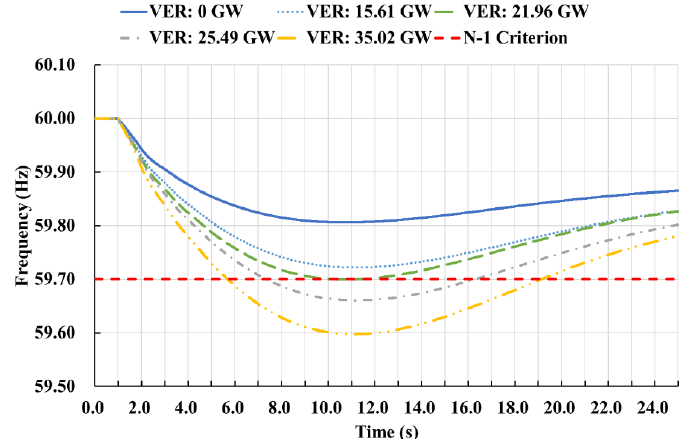
Figure 7. Frequency response characteristics under the N-1 disturbance depending on the penetration of VER under the medium load.